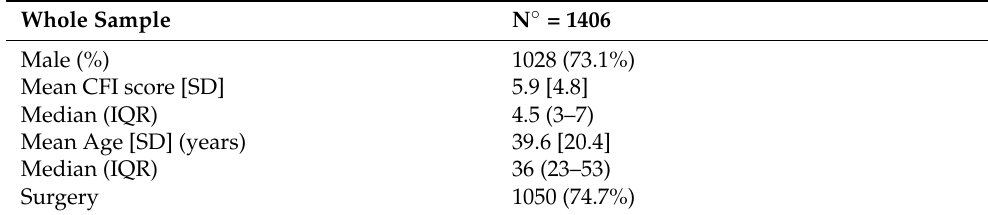
Table 1. Sample general characteristics and main outcomes. Whole